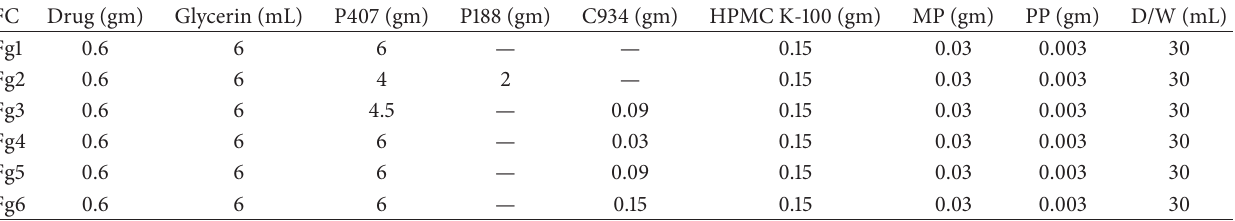
Table 2: Composition of the drug loaded formulations containing